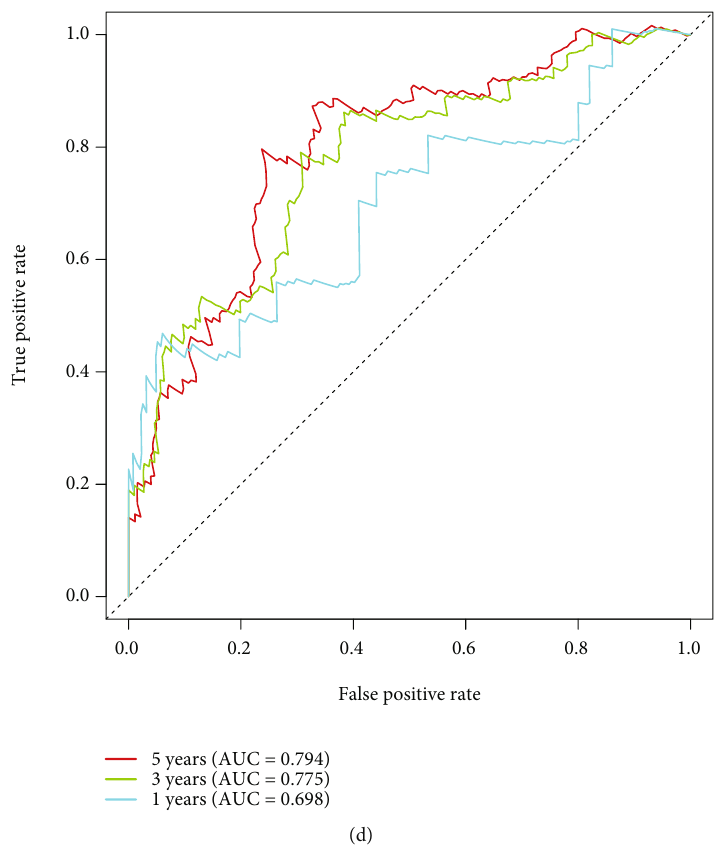
Figure 5: The prognostic value of the eight-ARG signature in the train set. (a) Distribution of risk score and patient survival status of cervical cancer. (b) Expression heat map of high-risk and low-risk groups. (c) The Kaplan – Meier (KM) curve demonstrates that patients in the high-risk group had a poorer prognosis. (d) Time-dependent ROC curve analysis for survival prediction by the risk